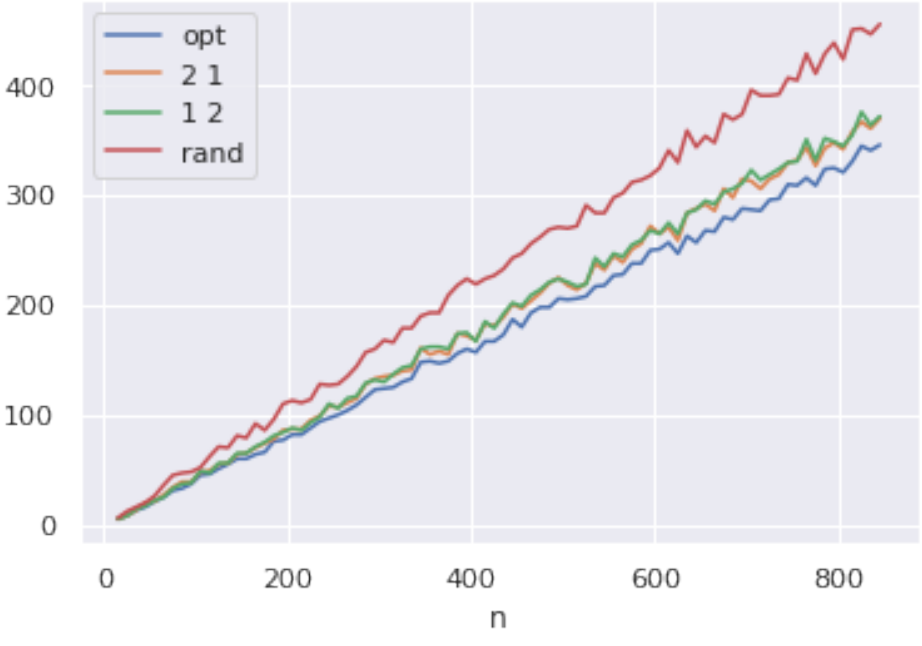
Figure 7. Returned values of carnality of minimal (1,2)-dominating sets for random